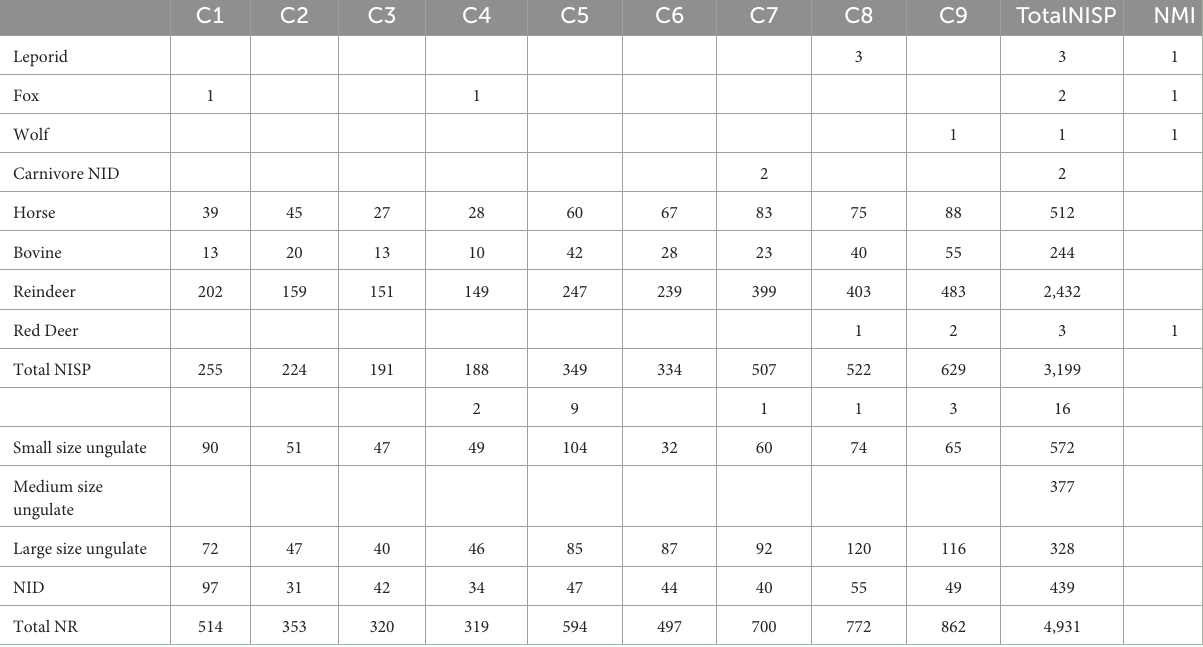
TABLE 1 Fauna spectrum per decapage (C1 to C9) expressed in number of remains (NR). MNIc was calculated on the combination of bone and